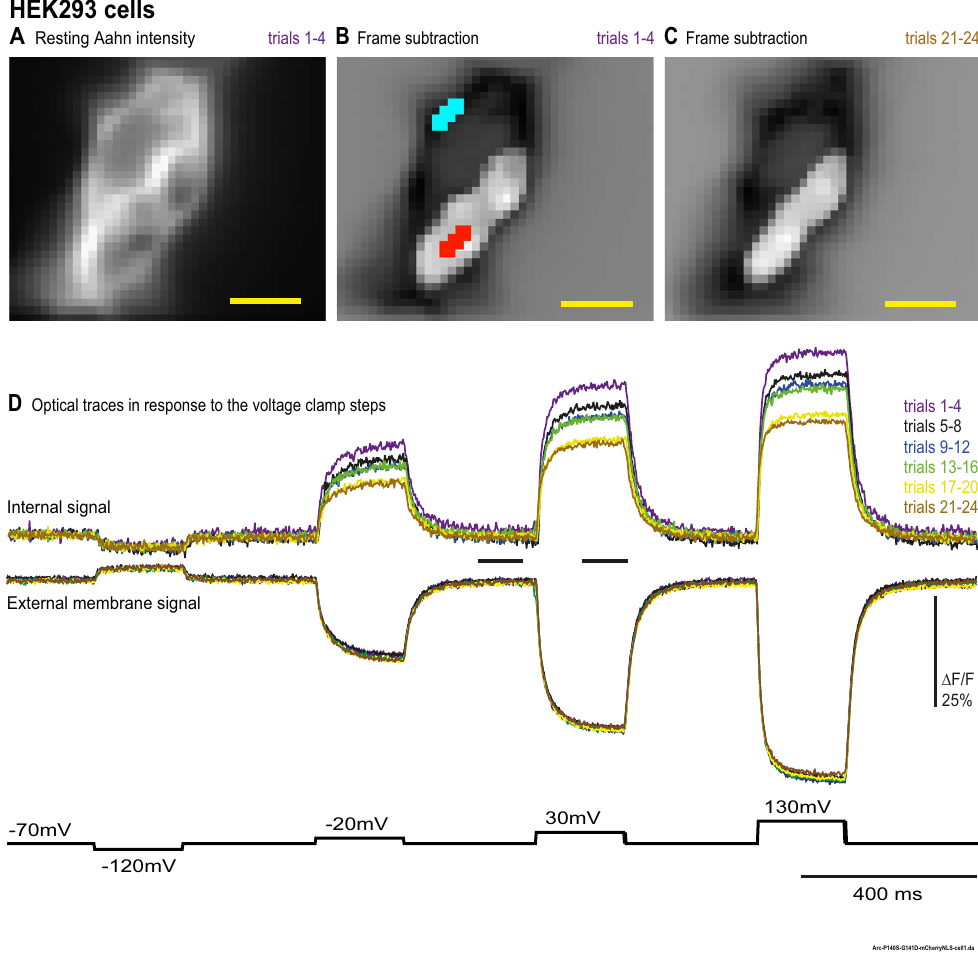
Figure 4. The internal optical signal size decreases during repeated patch clamp measurements in HEK293 cells. A HEK 293 cell (same cell that was illustrated in Figs 1 and 2) expressing Aahn was voltage-clamped. The internal signal, but not the external signal, decreases with repeated trials. ( A ) The resting light image of the Aahn expression. ( B , C ) Frame subtraction images for the first 4 trials and the last 4 trials (trials 21–24) in response to the 100 mV depolarization pulse. The internal signal area is somewhat smaller in the last group of 4 trials. ( D ) The optical traces of internal and external signals for the six sets of four trials are shown. Each trace is the average of 4 trials without temporal filtering. Images were recorded at a frame rate of 500 fps. The size bar represents 10 μ